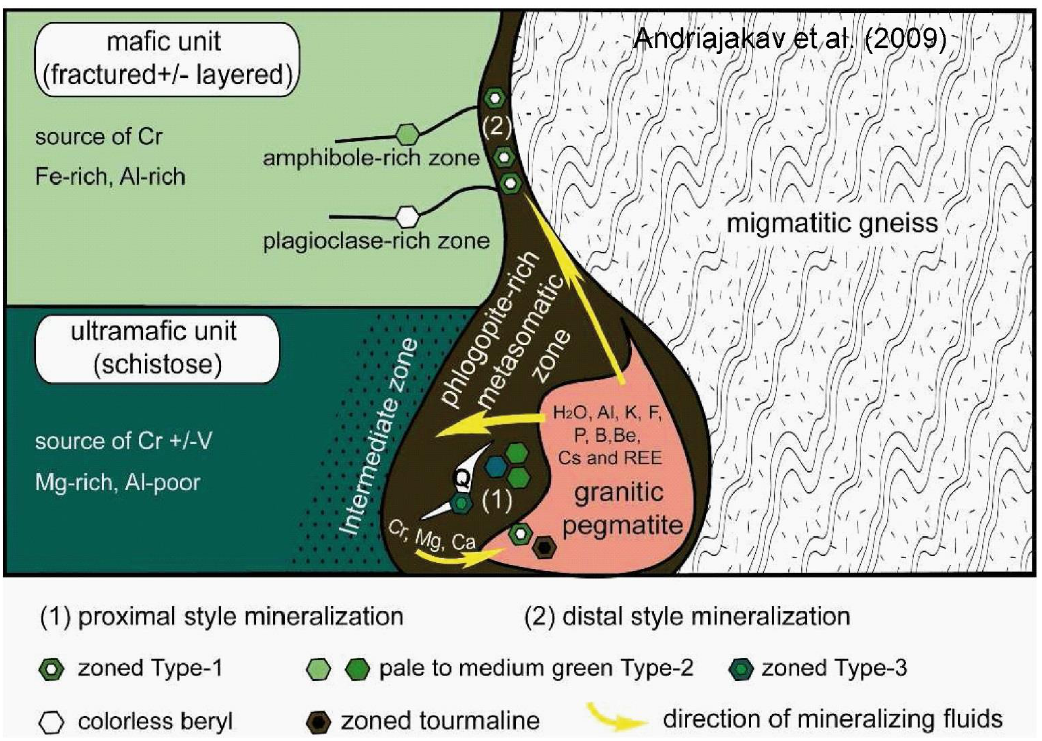
Figure 19. Schematic representation of the two styles of mineralization evidenced for the Ianapera emerald deposit, Madagascar: ( 1 ) Proximal mineralization occurs at the contact of pegmatite veins with ultramafic units. Emerald mineralization is hosted in metasomatic phlogopitite and desilicated pegmatites or quartz-tourmaline veins, at the contact between migmatitic gneiss and garnet amphibolite; ( 2 ) distal style is formed by phlogopite veins crosscutting mafic rocks. In addition to phlogopite, these veins contain Mg-amphibole, apatite, and dolomite, and minor quartz, calcite, zircon, plagioclase, and